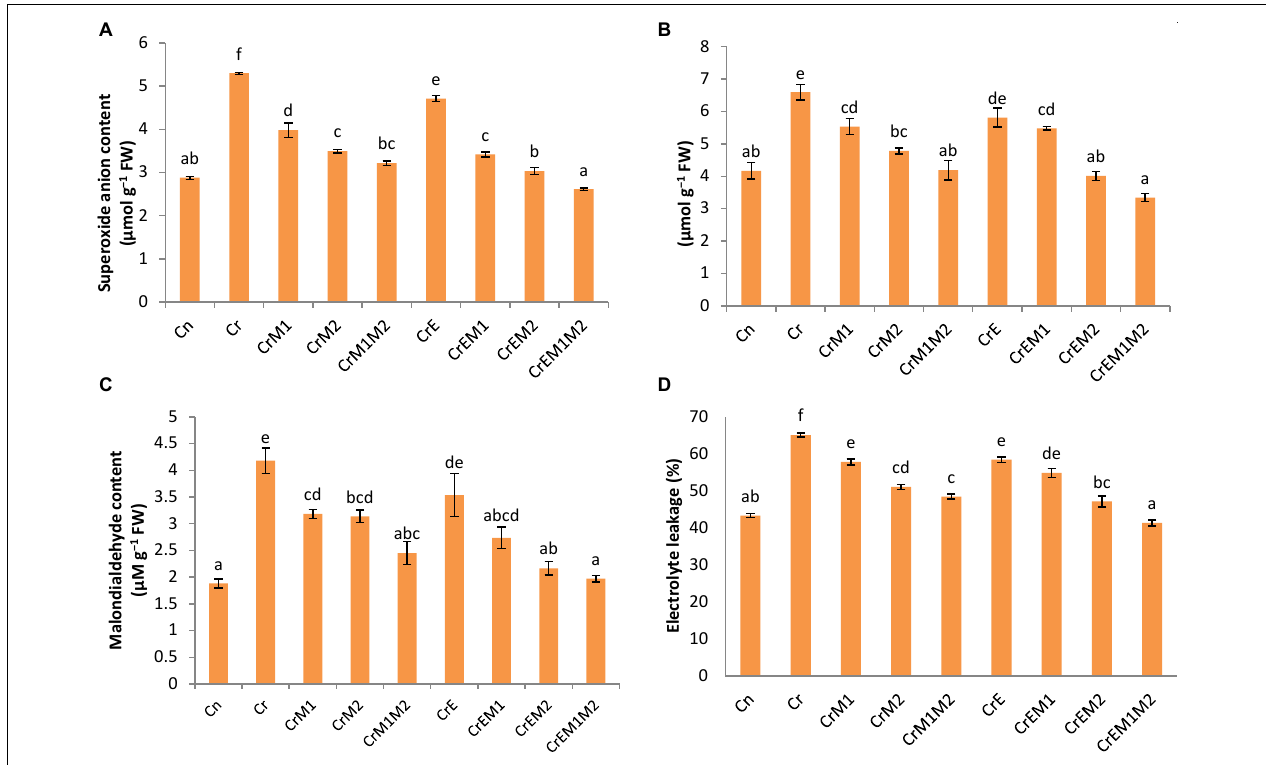
FIGURE 2 | Effect of PGPR [ Pseudomonas aeruginosa (M1) & Burkholderia gladioli (M2)] and earthworms [ Eisenia fetida (E)] on (A) superoxide anion, (B) hydrogenperoxide, (C) MDA content, and (D) electrolyte leakage in 10-day-old B. juncea seedlings, under chromium (Cr) stress. Data are presented as means of three independent replicates ± S.E (standard error). Different letters on the bar graphs indicate that mean values of the treatments are significantly different at p ≤ 0.05 (Tukey’s test).